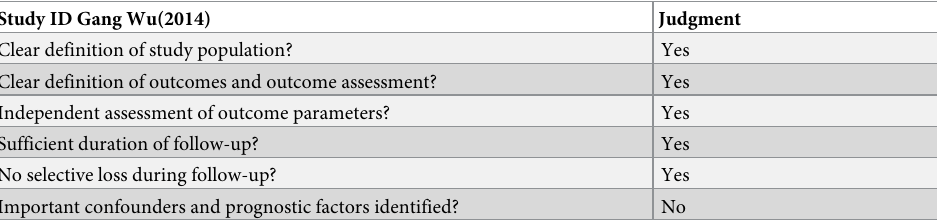
Table 5. Study quality for cohort study.